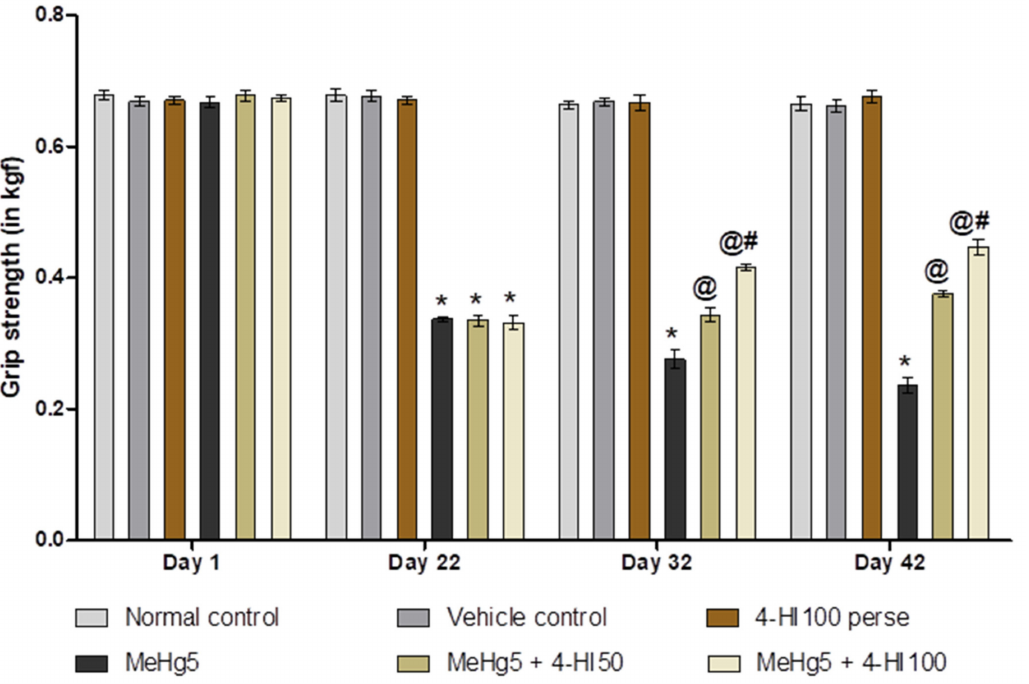
Figure 4. Effect of 4-hydroxyisoleucine on grip strength after methylmercury exposure in rats.Statistical analysis by two-way ANOVA (posthoc Bonferroni’s test). Values are expressed as mean ± SEM ( n = 6 rats per group). * p < 0.001 v/s normal control, vehicle control and 4-HI100 perse;